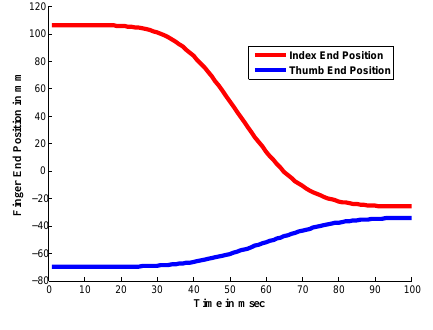
Figure10. Velocityprofilesof(a)ProstheticHandIndexFingerJoints(b)Human Hand Finger MCP (solid line) and PIP (dotted line) joints (Figure ’b’ adapted from [5]). FollowingSmith [28], the critical value of fingertip contact forcefor a sta- ble grasp is determined to be 3 Newton. Figure 11 shows the desired and actual fingertip contact force for Prototype 1.0 while performing a pinch grasp for 1 sec. After establishing the contact by the fingertip with the object to be grasped, critical fingertip force is stabilized through the PID controller. It prevents the fingertip force from exceeding a critical value with an steady state error of 0.1